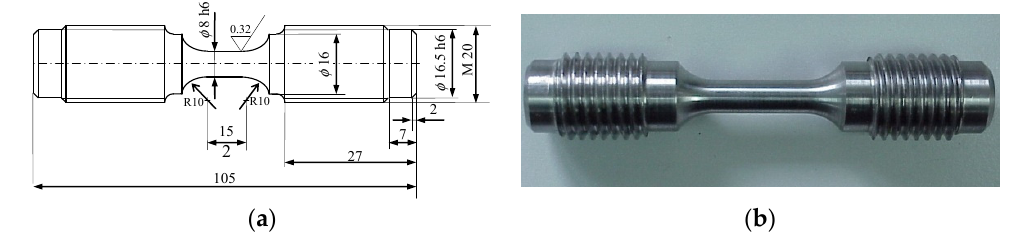
Figure 1. ( a ) Test sample dimensions (in [mm]); ( b ) test sample view.